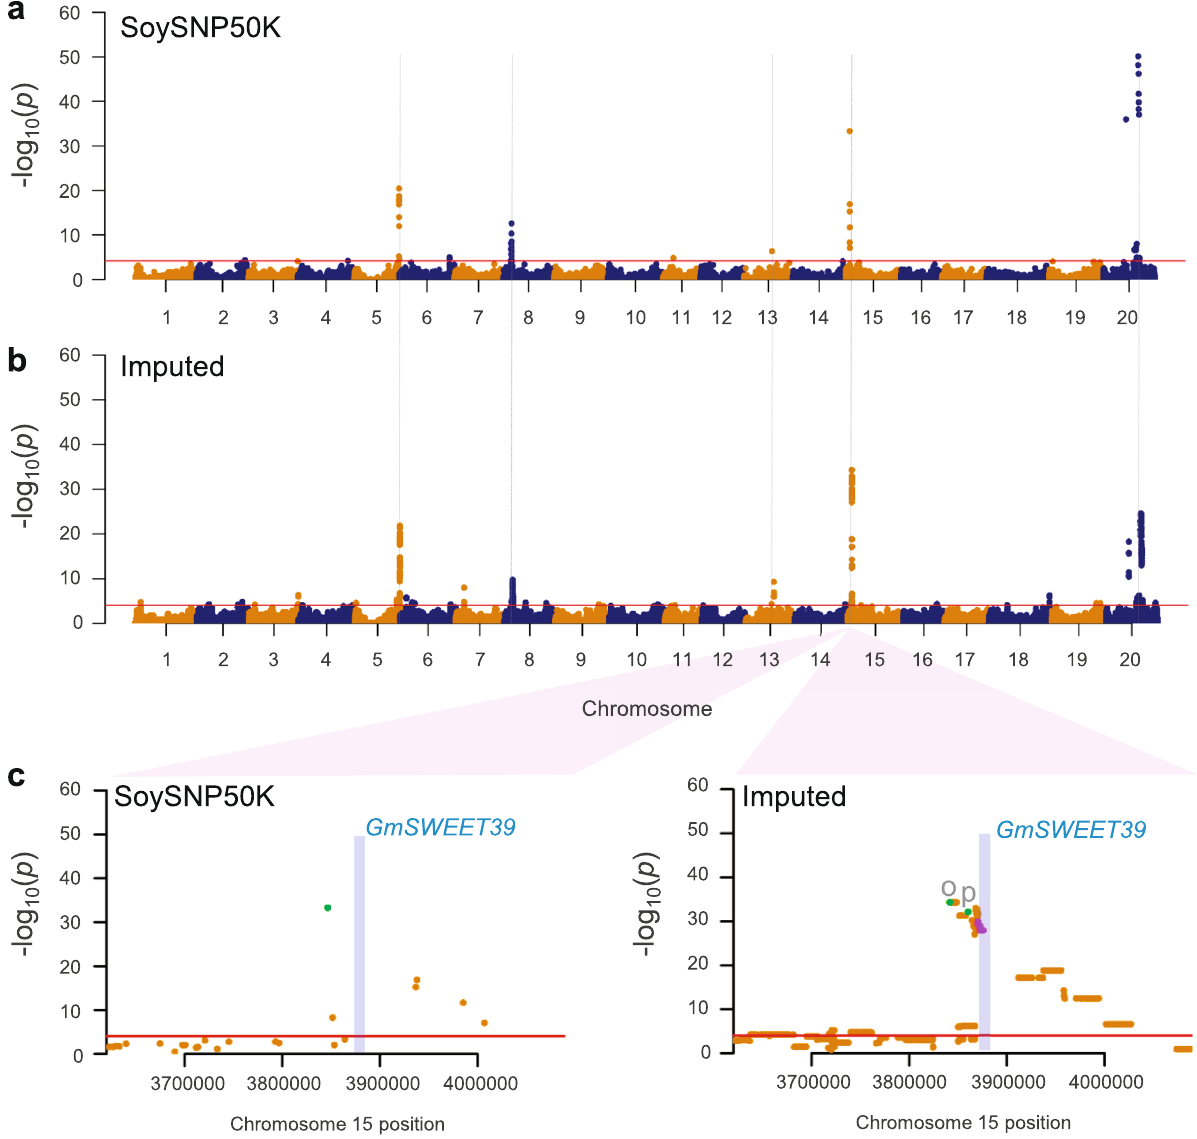
Fig. 5 Comparison of mvMLM-based GWAS for oil and protein contents using unimputed and imputed genotype data. a Results using the original genotype data from SoySNP50K array. Horizontal red line represents 5% signi fi cance thresholds corrected for multiple testing using Benjamini – Hochberg. Five major peaks are indicated by dashed vertical lines for comparison. b Results using 3.1 million SNP imputed data that imputed SNP data from 418 soybean genomes into SoySNP50K data. c Comparison of mvMLM-based GWAS results using unimputed (SoySNP50K) and imputed genotype data at a major peak on chromosome 15. A pale blue box indicates a chromosomal region of oil content regulator GmSWEET39 that includes its genic region and 5kb of each of its 5 ′ upstream and 3 ′ downstream regions. SNPs located in the GmSWEET39 region are highlighted by purple dots. A single peak SNP for the SoySNP50 data and unique single peak SNPs for each of protein (p) and oil (o) for the imputed data identi fi ed from the MLMM analysis are also highlighted by green